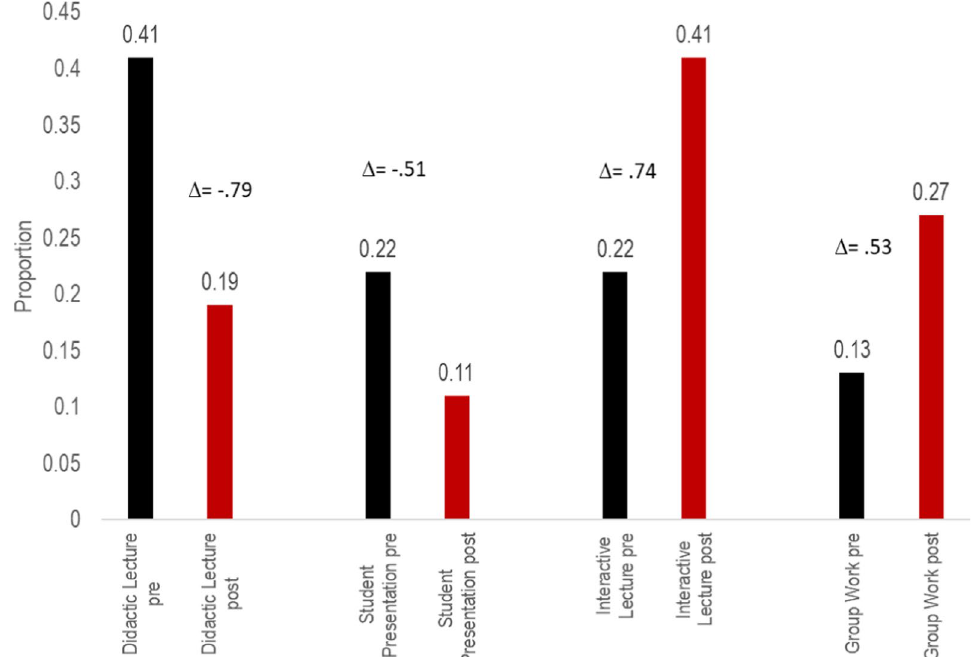
Fig. 7 Changes in Proportion of Latent Profiles from Pre to Post. Δ denotes effect size equal to the difference between pre post means divided by pooled standard deviation